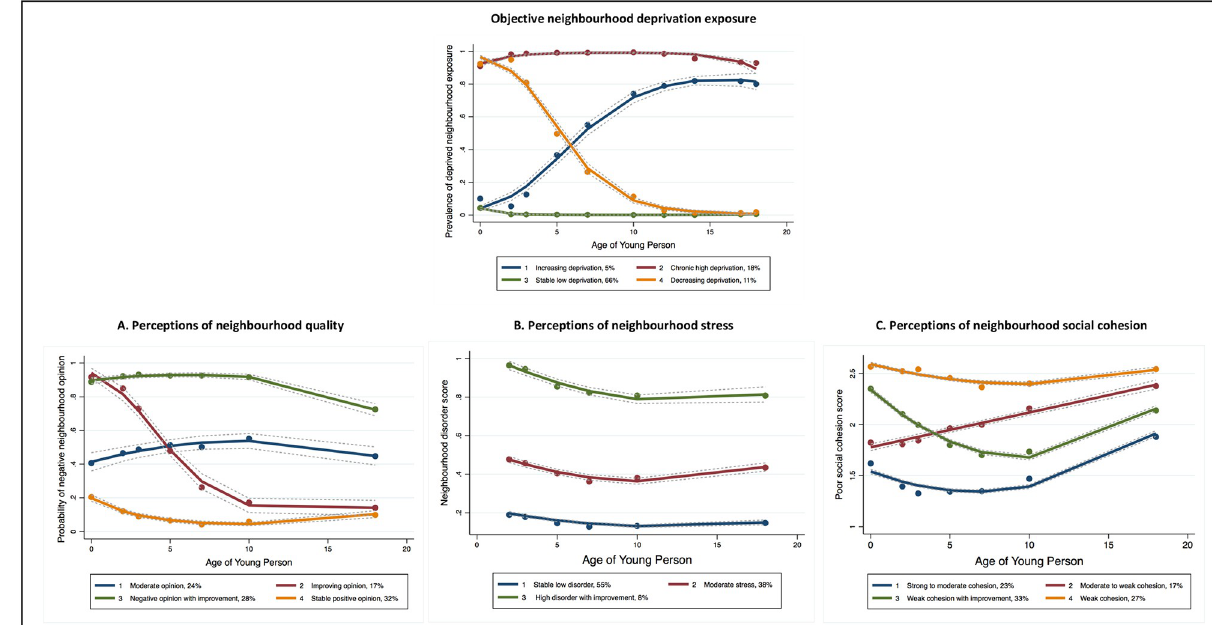
Fig 1. Dual trajectory models for objective neighbourhood deprivation and each perceived neighbourhood variable (N = 8,918). This figure summarizes the results from three dual trajectory analyses where the latent trajectories of objective neighbourhood deprivation exposure were estimated and compared to the latent trajectories of each of (a) perceptions of neighbourhood quality, (b) perceptions of neighbourhood stress, and (c) perceptions of neighbourhood social cohesion. The estimated trajectories for objective neighbourhood deprivation exposure are shown once for simiplicity. Solid lines are the estimated trajectories, dots are the observed group means for participating mothers at each assessment (labelled by the age of the young person participants, as per ALSPAC convention).